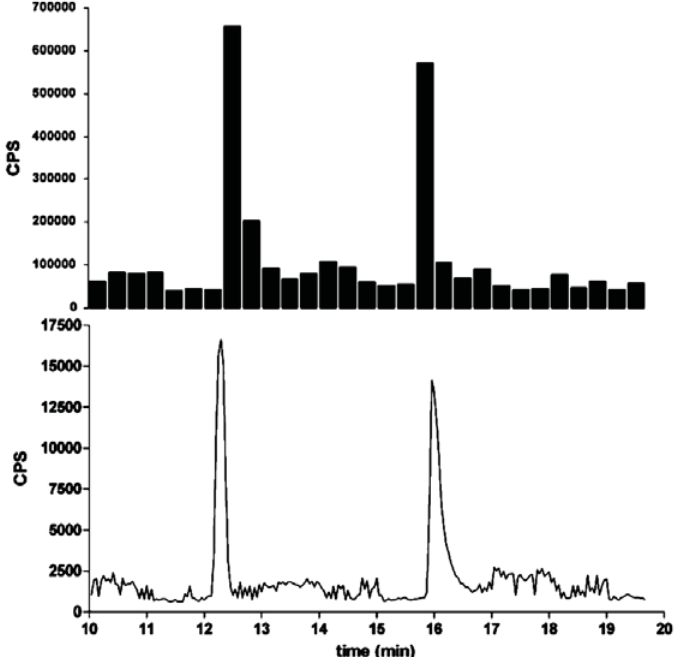
Figure 1. Comparison of parts of a fractionation in 96-well (20 s per fraction) and 1,536-well (2.5 s per fraction) microtitration plates (MTP). CPS counts per second. Reprinted with permission from [120]. Copyright (2009) American Chemical